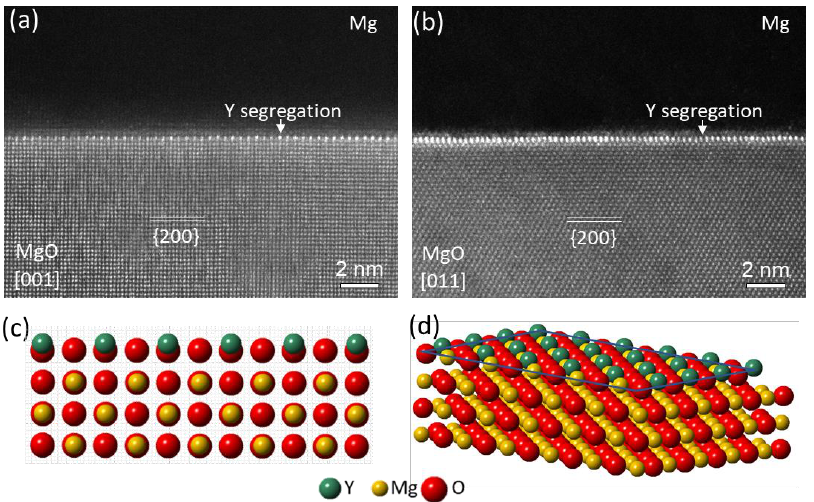
Figure 29. Nature of Y segregation layer at Mg/(1 0 0)MgO interface [28]. ( a , b ) High-resolution STEM HAADF images of (1 0 0)Mg/MgO interface viewed along ( a ) [0 0 1]MgO and ( b ) [0 1 1]MgO direction respectively, showing a bright atomic monolayer at the interface; and ( c , d ) schematics showing ( c ) segregated Y atoms viewed from [0 0 1] MgO direction and ( d ) 3D construction of the Y-containing monolayer on (1 0 0) surface of MgO.